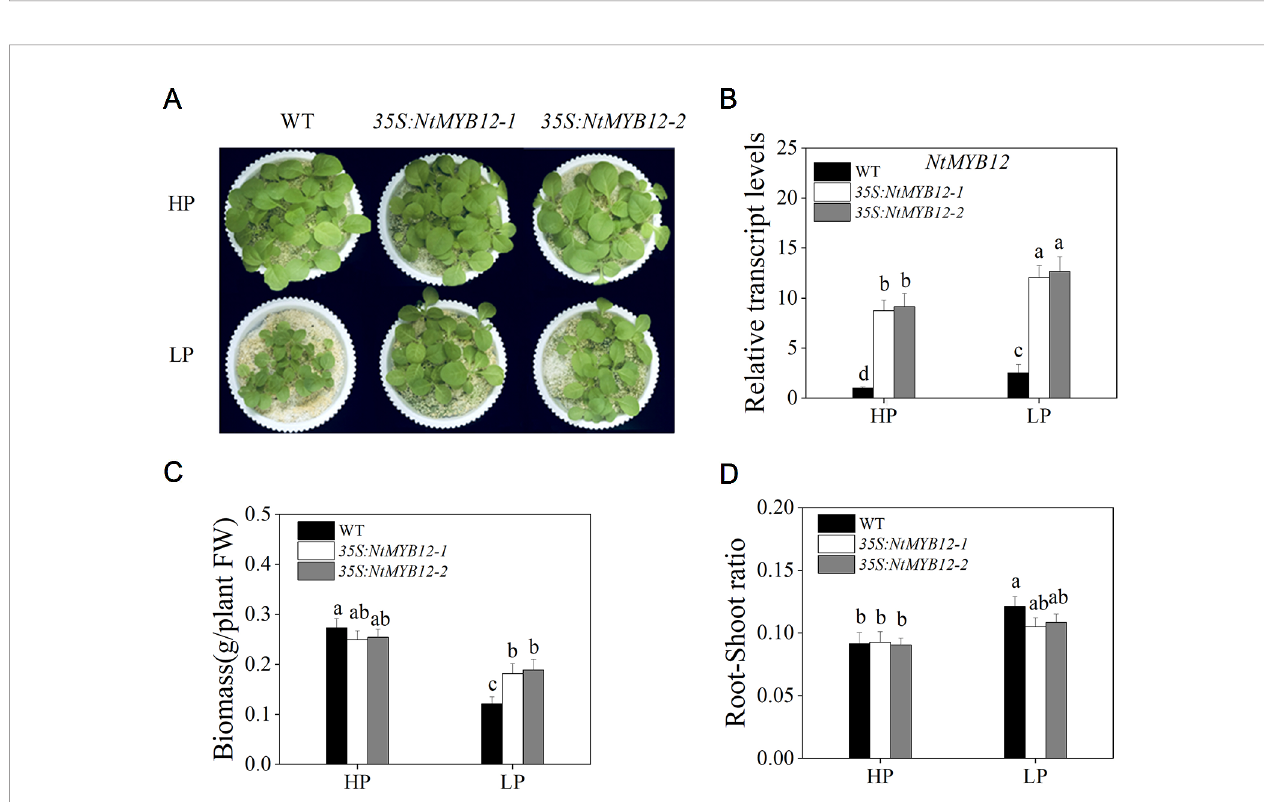
FIGURE 4 | Expression of NtMYB12 in transgenic tobacco and characterization of the WT and transgenic tobacco. (A) Characterization of the WT and transgenic tobacco under HP and LP conditions. (B) Relative transcript levels of NtMYB12 in WT and transgenic plants. (C) Biomass of the WT and transgenic plants under HP and LP conditions. (D) Root – shoot ratio of the WT and transgenic plants under HP and LP conditions. Sixteen-day-old seedlings were transferred to the full-strength culture solution and supplied with high Pi (HP; 1mM Pi) or low Pi (LP; 0.02mM Pi) for 21 days. FW, fresh weight. Data are the means ± SDs of fi ve biological replicates. Different letters indicate signi fi cant differences ( P < 0.05).